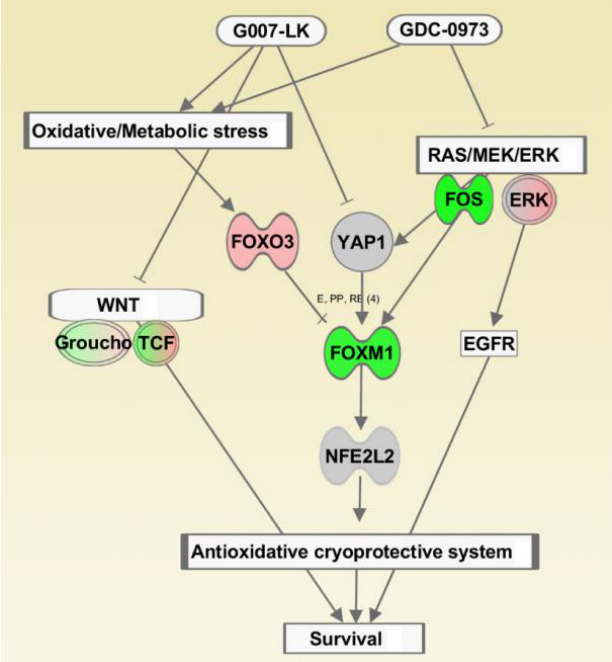
Figure 7. Proposed model of drug induced oxidative stress responses in HCT-15 cells. IPA generated model of drug induced stress responses in HCT-15 cells with an overlay of DEG’s (log2 fold >